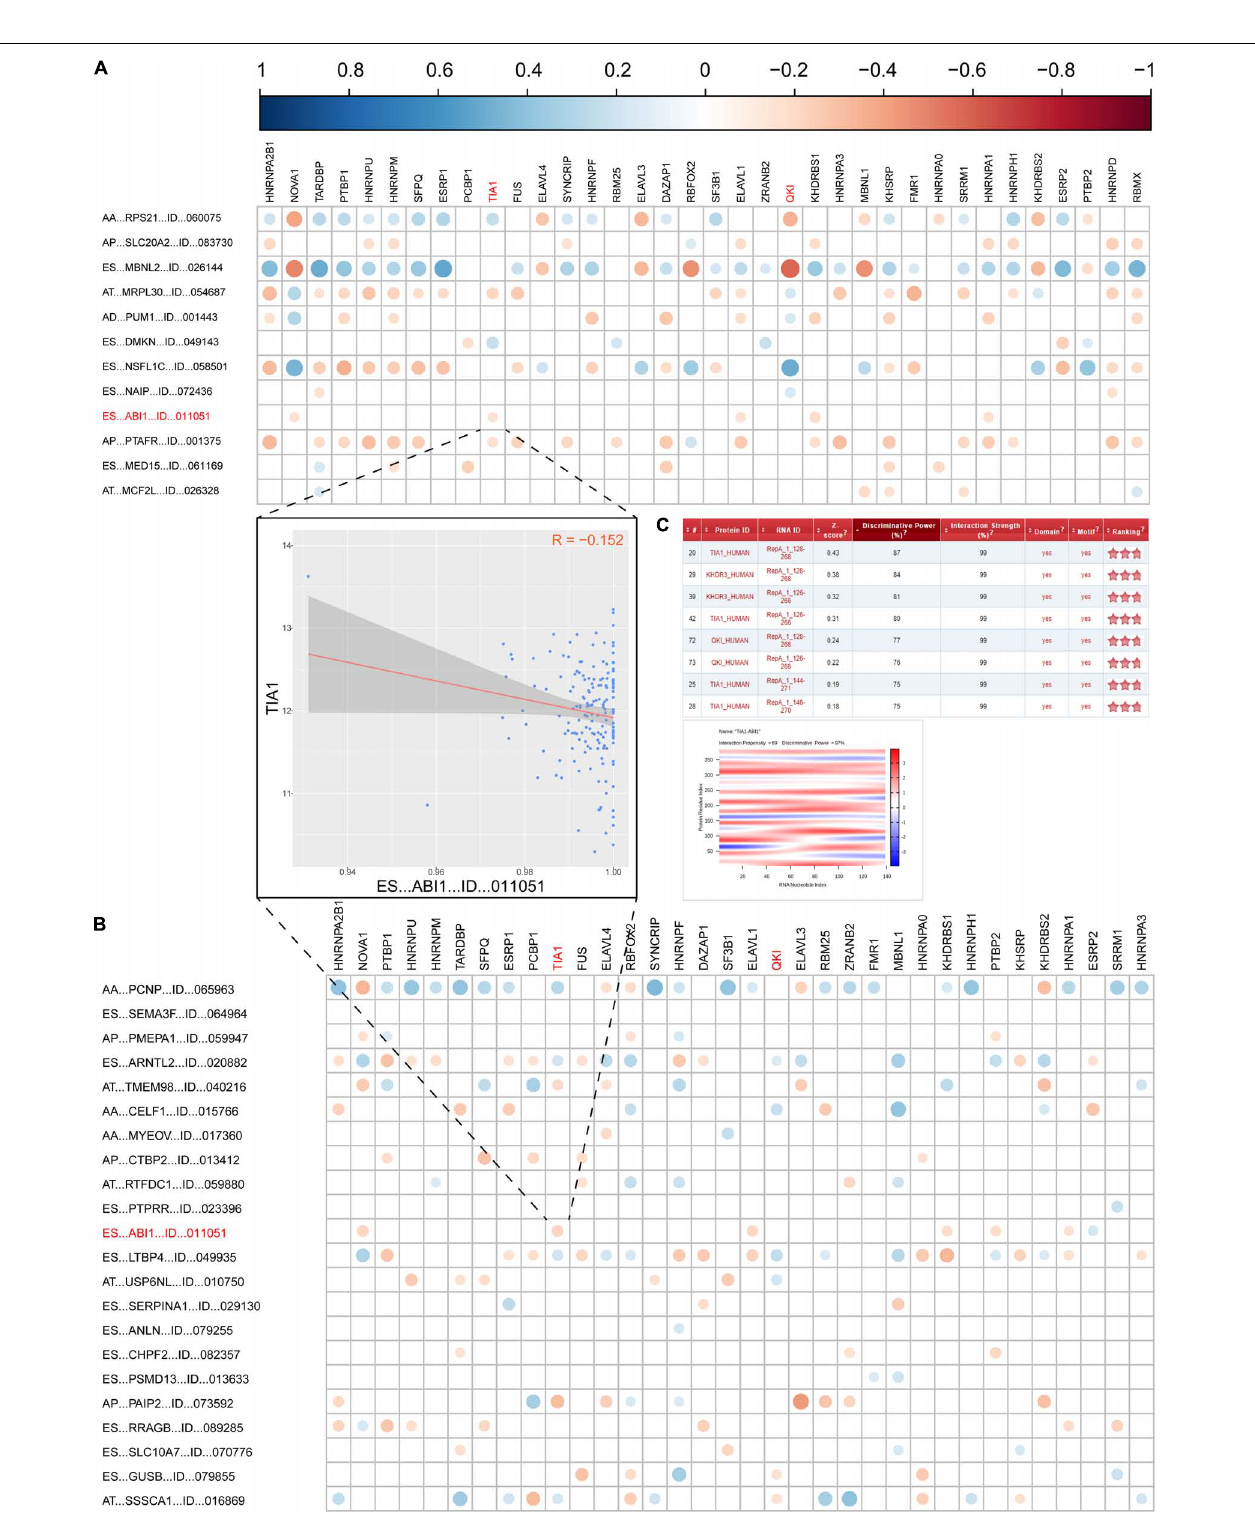
FIGURE 6 | Correlation analysis between splicing factors and DEAS prognostic predictors. (A) the correlation between OS-related DEAS and splicing factors. (B) The correlation between DFS-related DEAS and splicing factors. The weight of the correlation coefficient was represented by the size and color of the circle. (C) The correlation between TIA1 and ES_ABI1. The left graph shows the correlation between the TIA1 and ES_ABI1. The right figure shows the interaction score and site prediction.